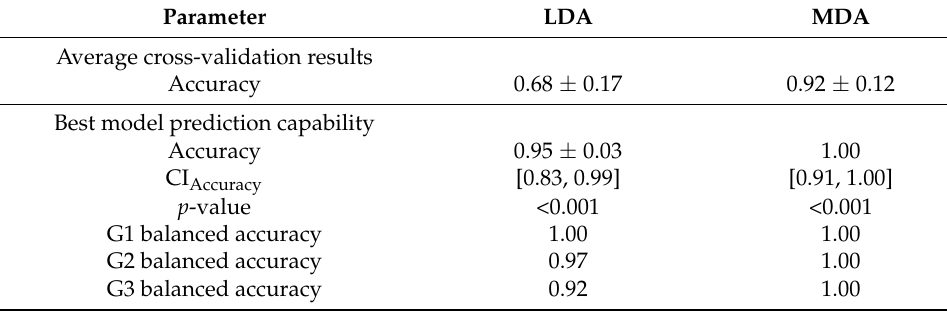
Table 2. Evaluation parameters of the LDA and MQA